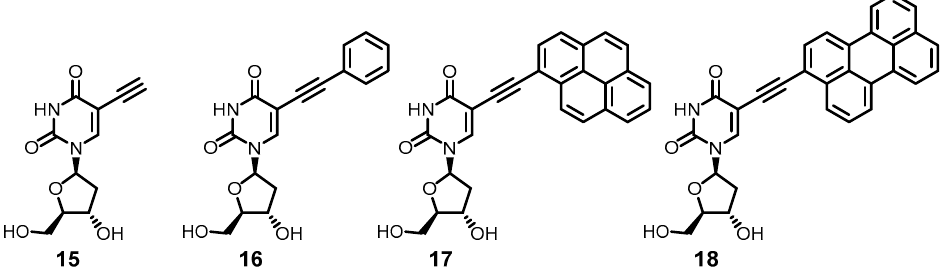
Figure 5. 5-Alkynyl-2 ′ -deoxyuridines.